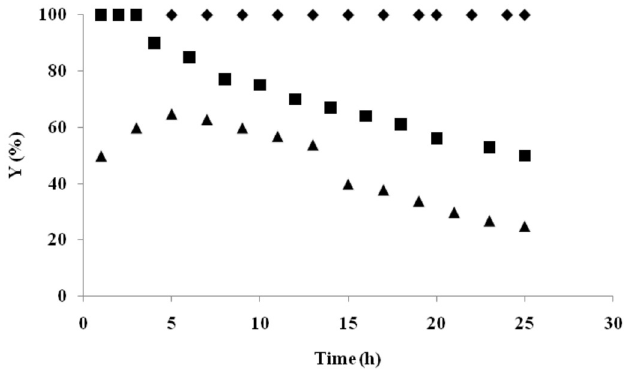
FIGURE 2 - Variation in conversion during continuous sucrose hydrolysis catalyzed by soluble invertase [test 2 (  )] and immobilized invertase [test 5 (  ) and test 6 (  )]. In all tests, the protein loading was equal to 3.28